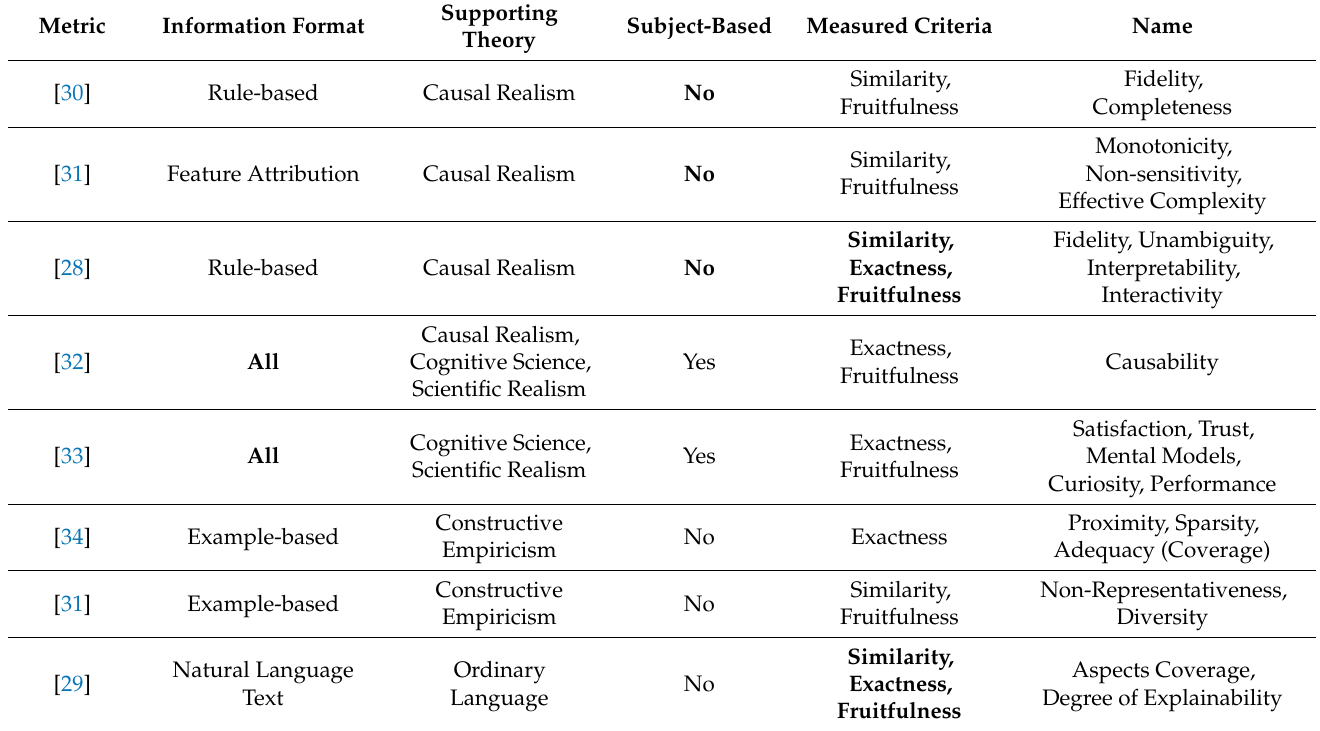
Table 2. Comparison of different explainability metrics. The column “Metric” points to reference papers, while column “Name” points to the names used by the authors of the metric to describe it. Elements in bold are column-wise, indicating they are the best